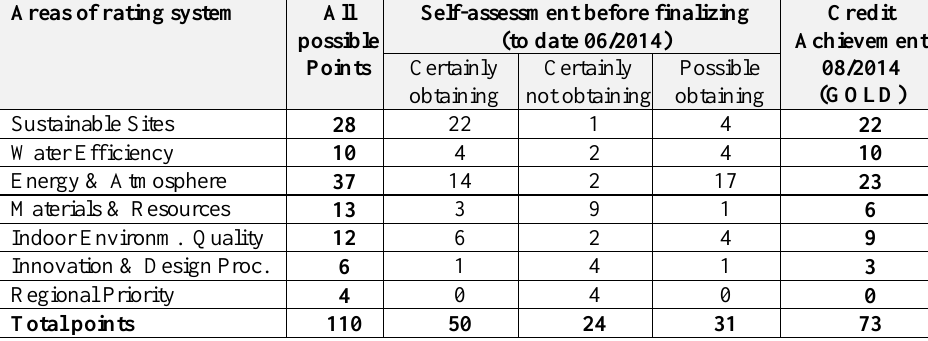
Table 4 – The assessment progress of EcoPoint Office Center by LEED system Areas of rating system All Self-assessment before possible Points